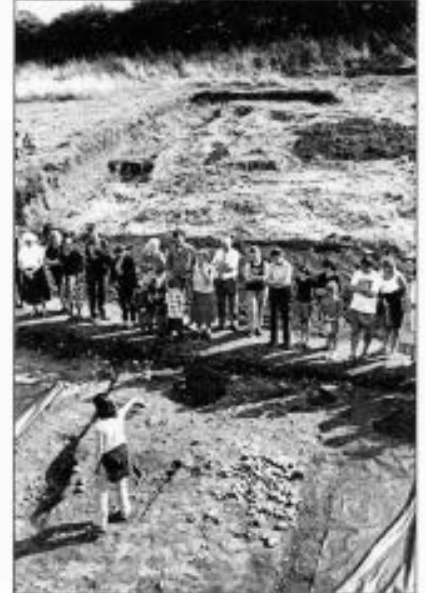
Figure 7 Public archaeology at Sedge­ ford: a member of the team explains the excavation on the lower terrace of the Boneyard site to a group of visitors (some of whom may later join the project, learn new skills and become active participants in archaeological